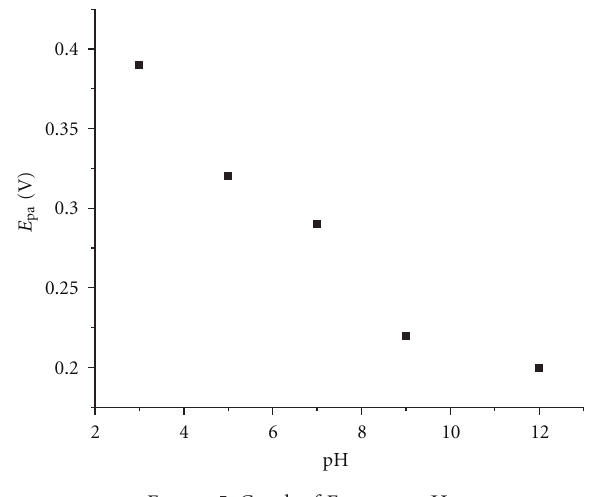
Figure 5: Graph of E pa versus